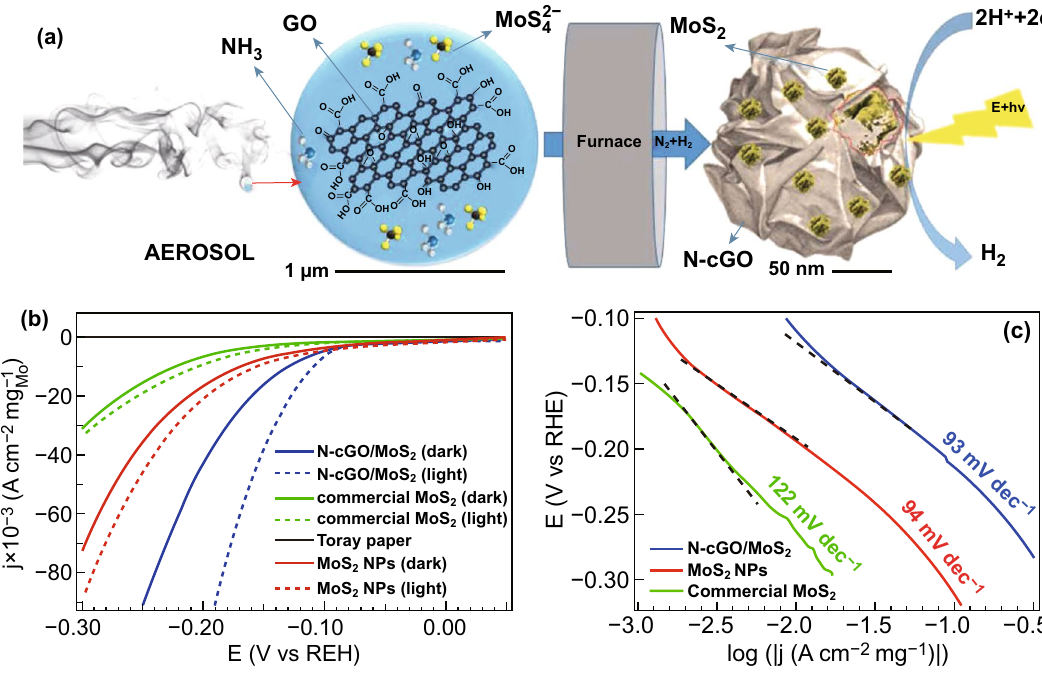
Fig. 5 a Synthesis scheme of N-cGO/MoS 2 ; b polarization curves in dark and under illumination and c Tafel plots for N-cGO/MoS 2 , MoS 2 NPs, and commercial MoS 2 in 0.5 M H 2 SO 4 . Reproduced with permission from Ref. [105]. Copyright 2015 American Chemical